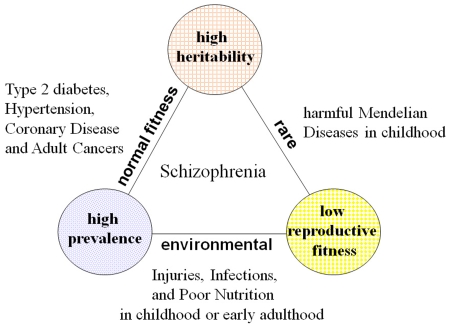
Devil's triangle of high heritability, high prevalence and low reproductive fitness.The three epidemiological properties-high heritability, high prevalence and low fitness- form a Devil's triangle; any combination of the two tends to exclude the third. In this triangle most diseases vanish except for schizophrenia.